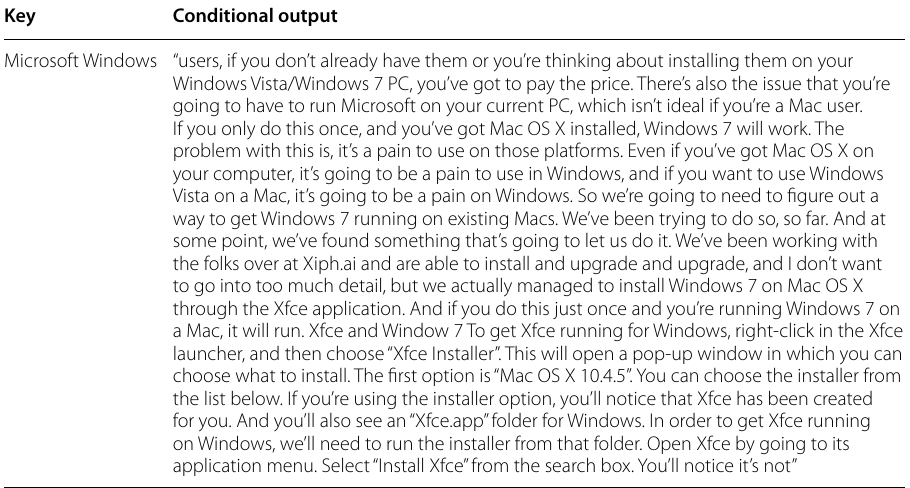
Automatic output generated by the trained model against user given topic/key